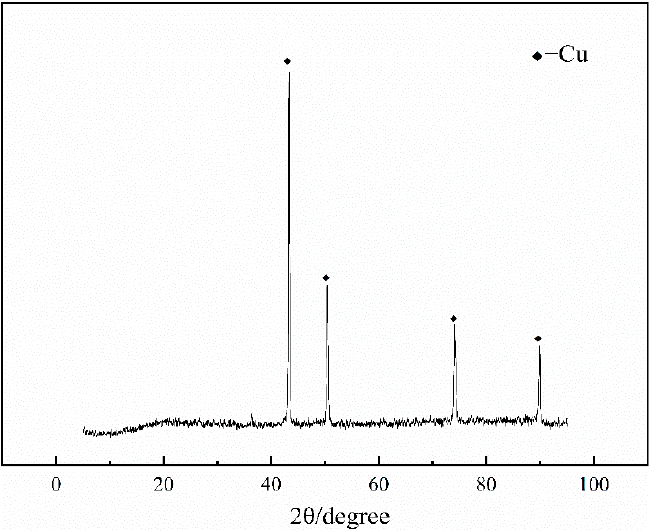
Figure 1. X-ray diffraction pattern of WPCB powder ( − 250 μ m) before bioleaching. Figure 1. X-ray di ff raction pattern of WPCB powder ( − 250 µ m) before